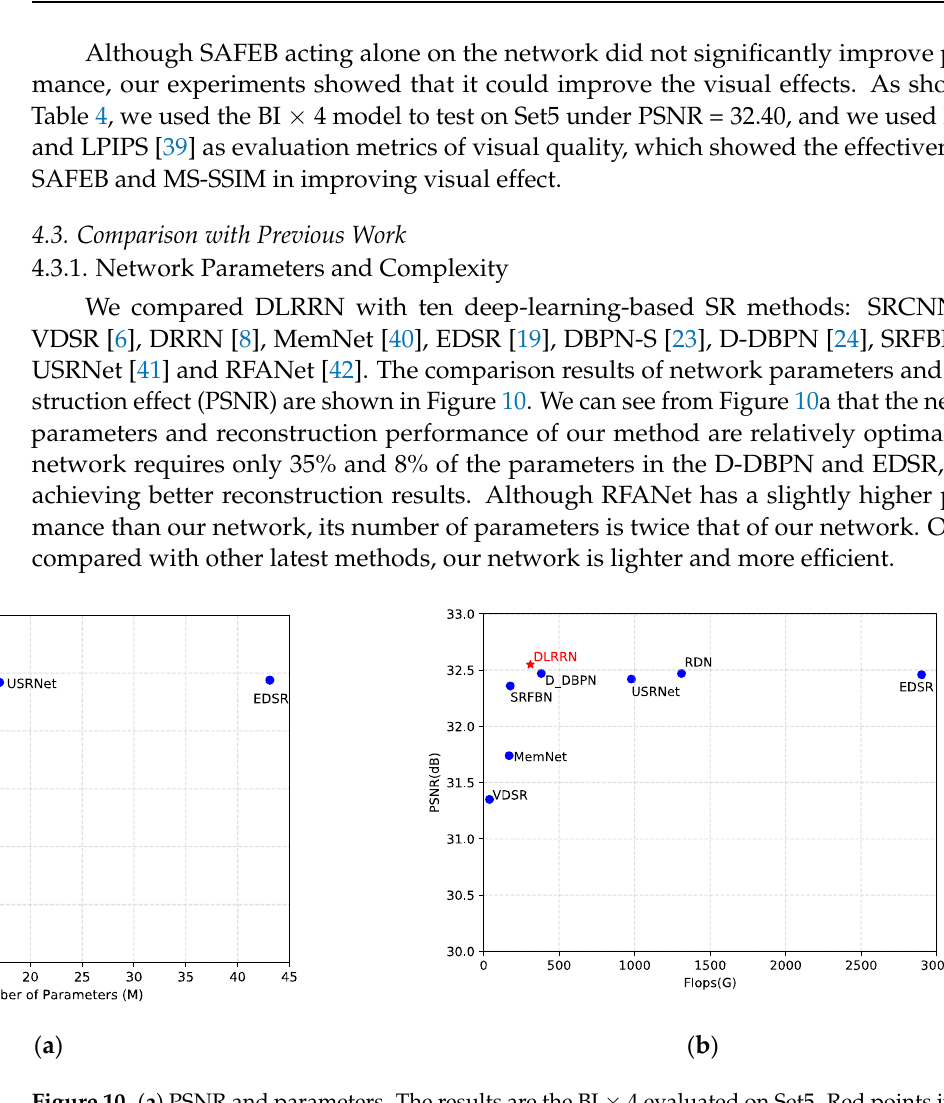
Table 5. Ablation analysis of SAFEB.